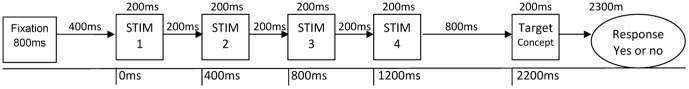
Picture, high imageable word, and low imageable word.The words were originally in Chinese during the study.